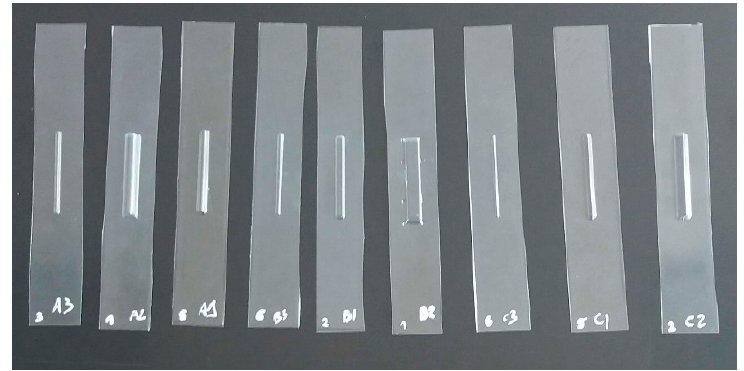
Figure 7. Thermoformed specimens.